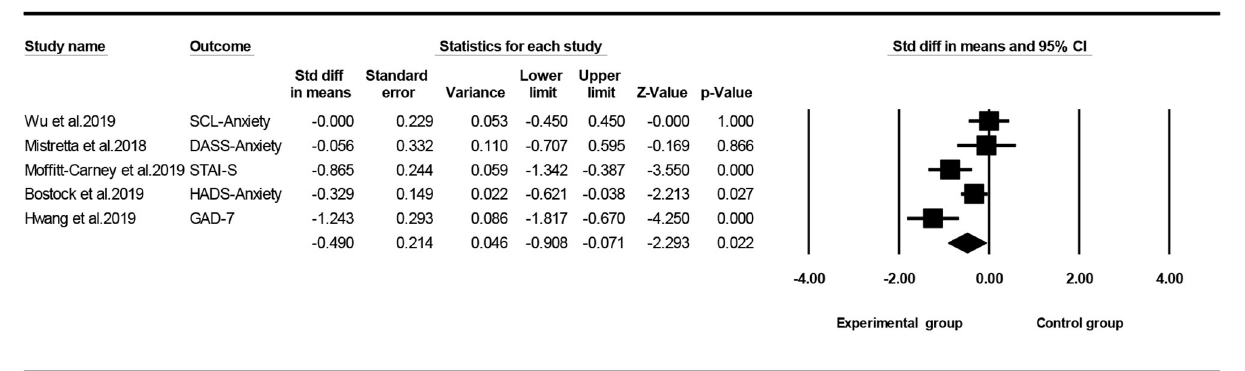
FIGURE 9 | Forest plot for anxiety.